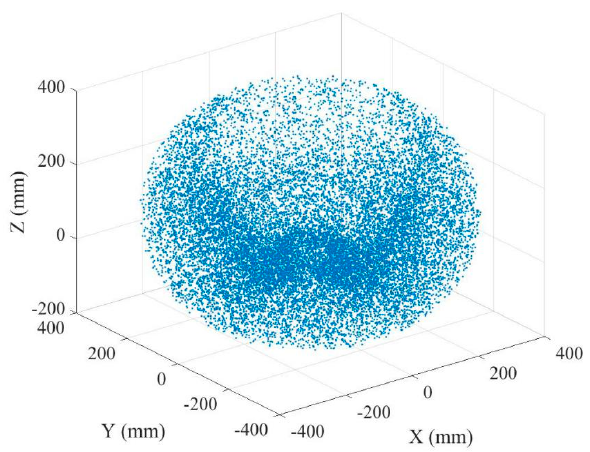
Figure 5. Workspace point cloud.